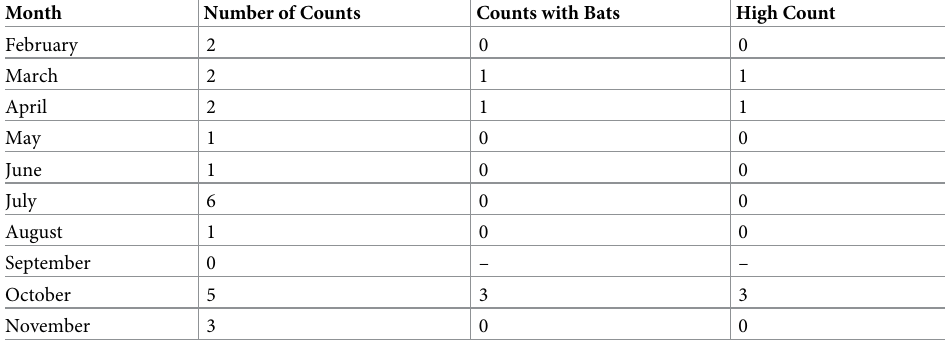
October November 0